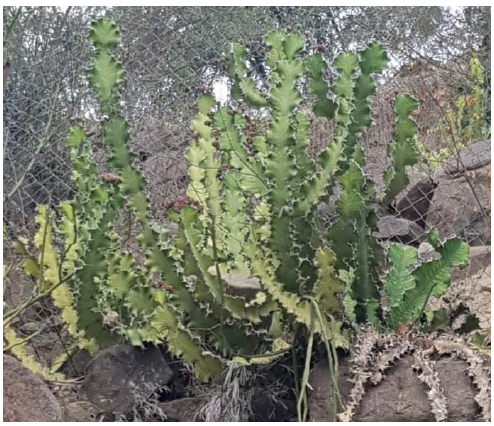
Figure 3. E. cactus aerial parts growing in Fayfa mountain, Saudi Arabia.